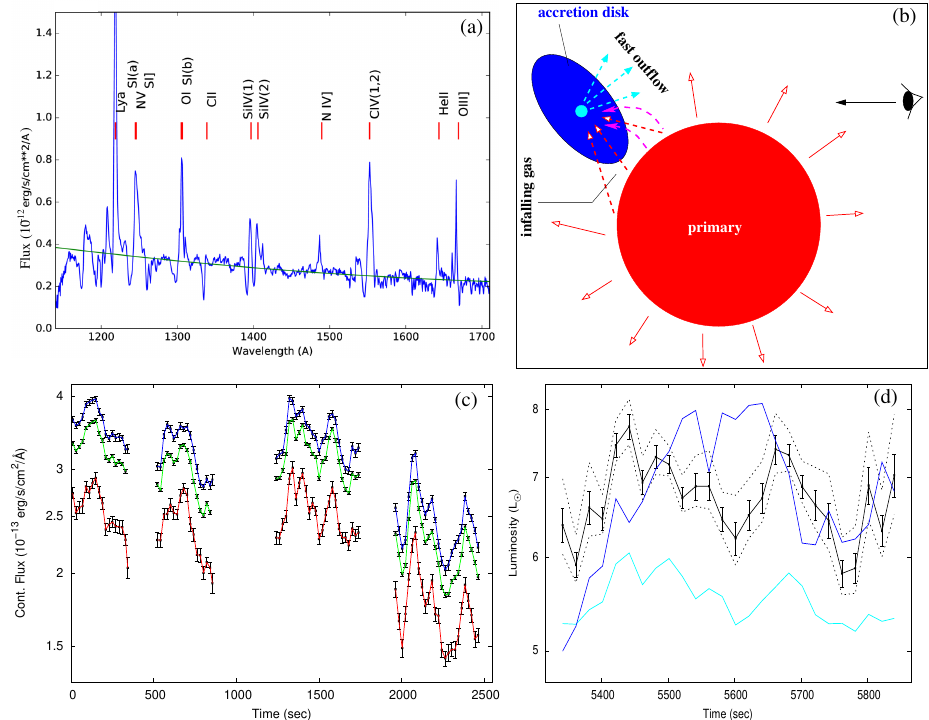
Figure 2. ( a ) STIS/UV spectrum of YGem and model fit (green curve) consisting of two blackbody components— T eff = 35,500 K, L = 6.3 L (cid:12) and T eff = 9400 K, L = 6.7 L (cid:12) . ( b ) Schematic model geometry (not to scale) to explain the Doppler shifts of the absorption and emission features observed in the UV spectra: the blue ellipse shows an accretion disk around a compact companion; dashed red/pink arrows show two possible infall streams resulting from material in an outflow or Roche-lobe overflow (red arrows) from the primary AGB star (red circle); ( c ) short-term time variations in the ( c ) FUV continuum: line-free continuum in the bands 1346–1367Å (blue) and 1571–1600Å (red), continuum underlying the Si IV(1) line (green), and ( d ) short-term time variations in the luminosity (black) of the high-temperature accretion component: the dashed curves show bounds on the lumi- nosity due to the estimated uncertainties in the cooler blackbody’s luminosity and temperature. The 1571–1600Å continuum, scaled up by a factor 1.1 × 10 7 (cyan), and the square-root of the SiIV(1) absorption line equivalent width, scaled up by a factor 5.2 (blue), are shown for comparison ( adapted from Sahai et al. (2018) [16]